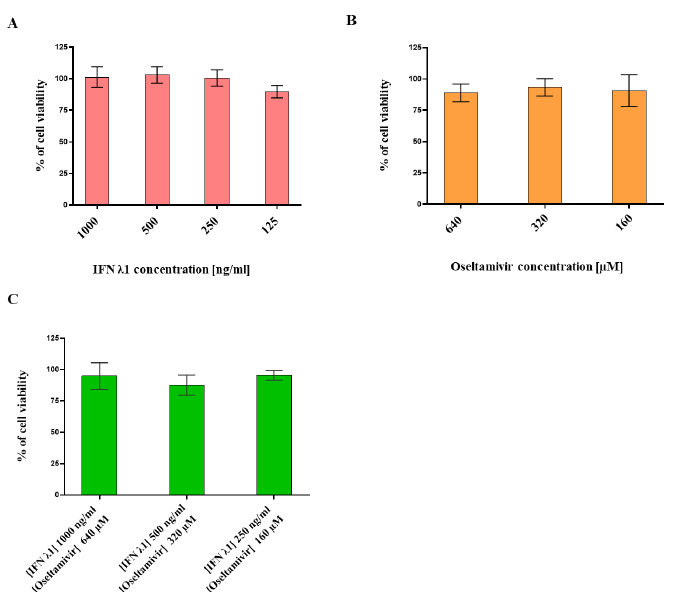
Figure 1. Viability assessment of Calu-3 cells grown in the presence of a dose range of IFN λ1 and OS administered alone or in combination. IFN λ1 treatment ( A ), OS treatment ( B ), IFN λ1 plus OS co-treatment ( C ). Cell viability was measured by MTT assay. The % of cell viability was calculated based on an untreated control at 48 h post treatment. The results represent the mean and standard deviation from two independent experiments performed in duplicate. IFN λ1 = human IFN λ1; OS = Oseltamivir.